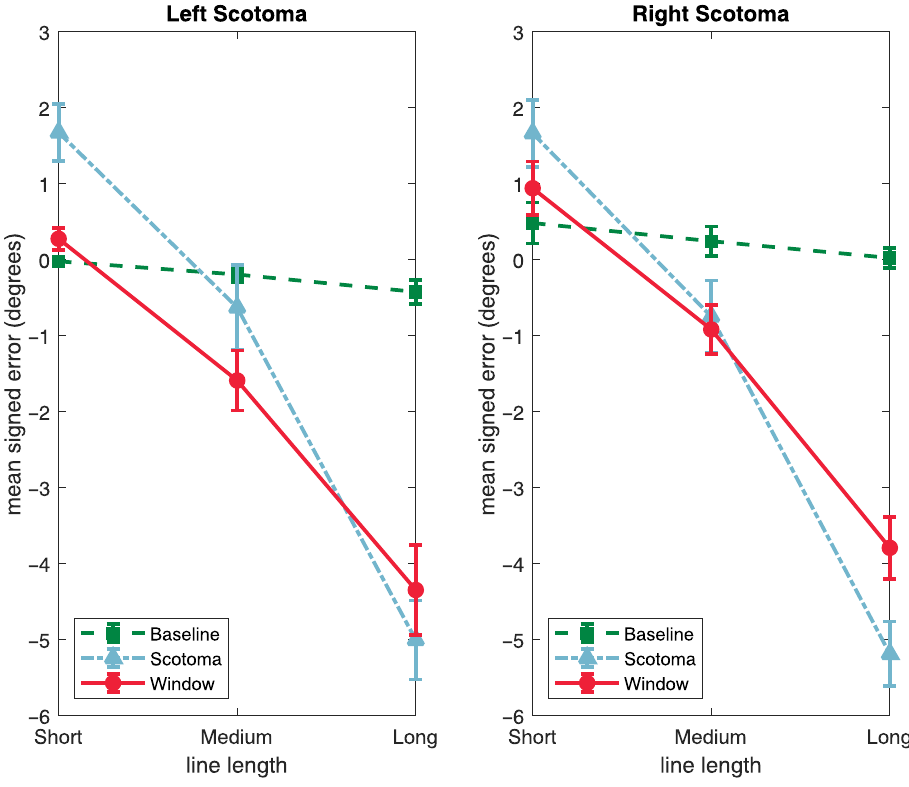
Figure 5. Negative errors are an underestimation where positive errors are an over